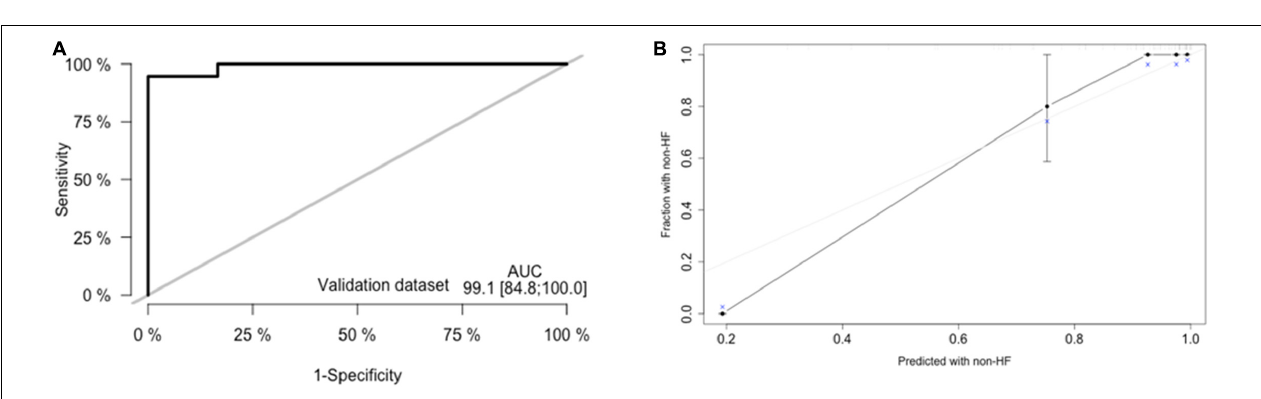
FIGURE 5 | Performance of the predictive nomogram for probabilities of heart failure. (A) Receiver operating characteristic (ROC) curve analysis for predicting heart failure. The area under the curve (AUC) for combining MB, PR, and LAVI was 0.751 (95% CI: 0.616–0.886) (Model 1). When Lat-QSb and Lat-QSt were added to the above model (Model 2), the AUC was 0.948 (95% CI: 0.885–1.000, p < 0.001). (B) Calibration plot of the predictive nomogram for predicting the probabilities of heart failure. An ideal calibration plot is indicated by a 45 ◦ diagonal grey line. Lat, lateral wall; QSb, from the onset of Q wave on ECG to the beginning of S wave on TDI; QSt, from the onset of Q wave on ECG to the top of S wave on TDI; MB, myoglobin; LAVI, left atrial volume index; PR, PR interval.